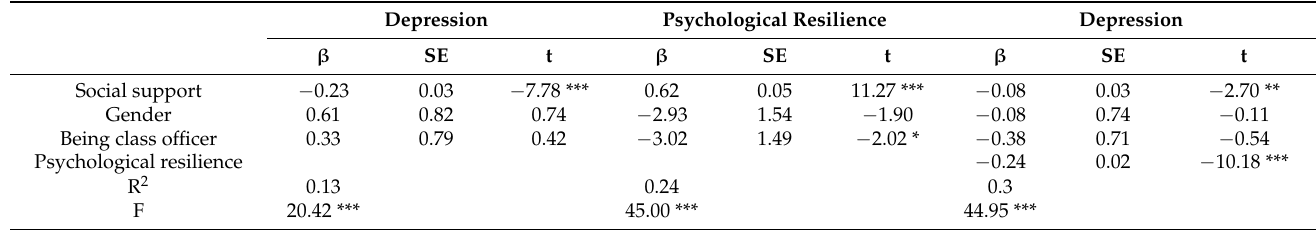
Table 3. The mediating effect of psychological resilience (N = 424).